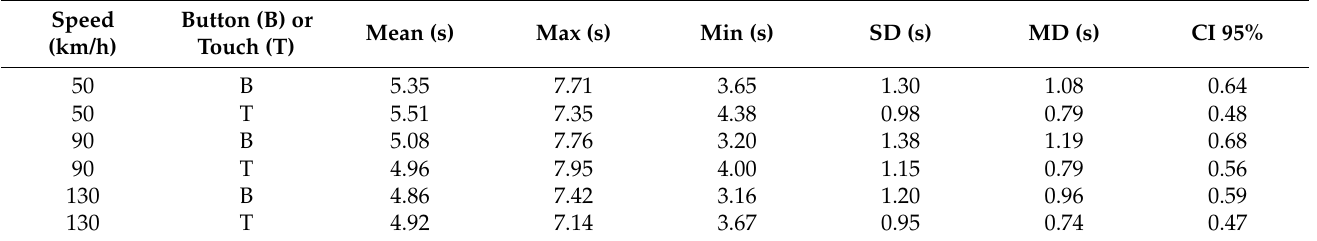
Table 4. SHD and statistical values.